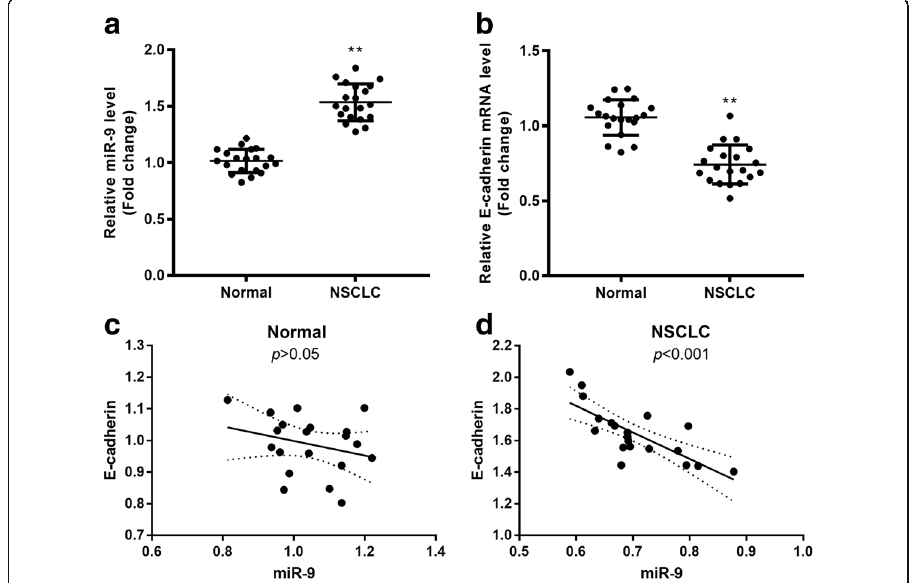
Fig. 1 Expression of miR-9 and E-cadherin in human NSCLC. In human NSCLC tissue and adjacent normal tissue, the relative expressions of miR-9 ( a ) and E-cadherin mRNA ( b ) were assessed with qRT-PCR. ** p < 0.01 vs. normal control. The correlations between miR-9 and E-cadherin in adjacent normal tissues ( c ) and NSCLC cancer tissues ( d ) were determined using Pearson